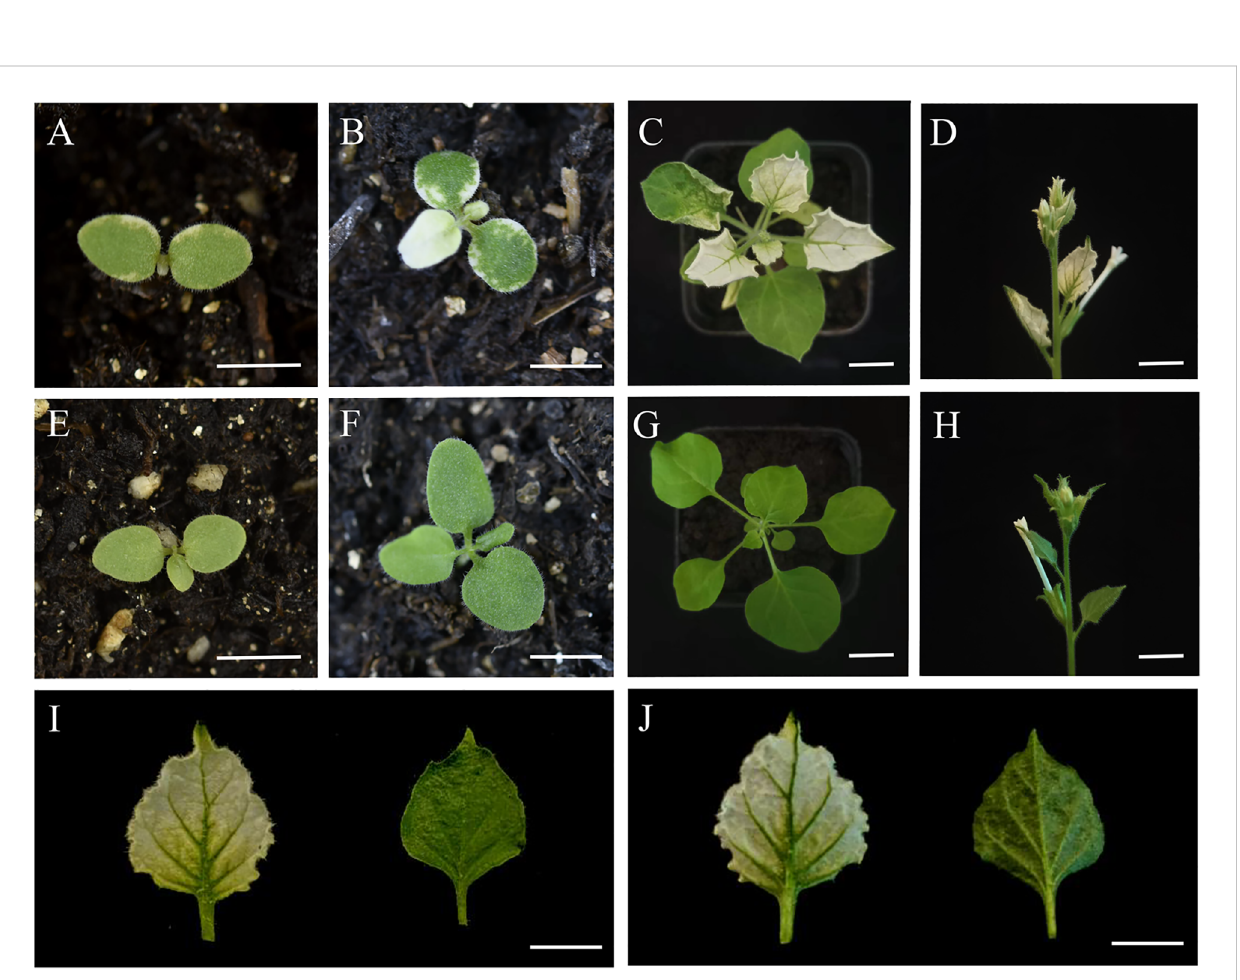
FIGURE 7 Phenotypic observations in transgenic and WT plants of Nicotiana tabacum. (A-D) transgenic tobacco. (E-H) Wild-type tobacco. (I) Upper blade surface. (J) Lower blade surface. The length of white bar represents 1000µm.